Question: Describe this figure in one sentence.
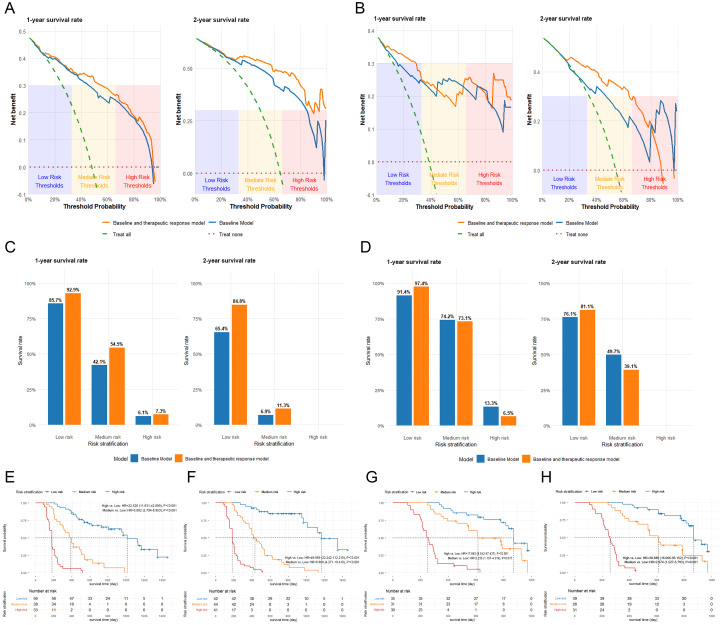
Answer: Clinical benefits and risk stratification. (A) Decision curve analysis of 1-year and 2-year survival rates in the training cohort; (B) Decision curve analysis of 1-year and 2-year survival rates in the external validation cohort; (C) The 1-year and 2-year survival rates histogram for risk stratification in the training cohort; (D) The 1-year and 2-year survival rates histogram for risk stratification in the external validation cohort; (E) Survival curves for risk groups based on risk stratification of the baseline model in the training cohort; (F) Survival curves for risk groups based on risk stratification of the integrated model in the training cohort; (G) Survival curves for risk groups based on risk stratification of the baseline model in the external validation cohort; (H) Survival curves for risk groups based on risk stratification of the integrated model in the external validation cohort. HR, hazard ratio.